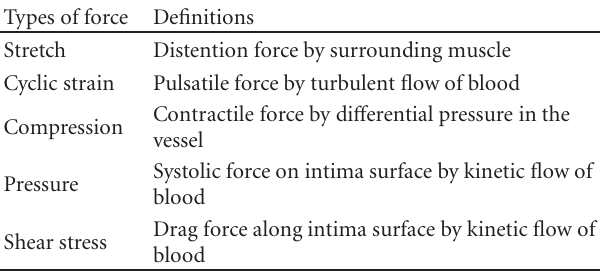
Table 1: Mechanical forces in the blood vessel.